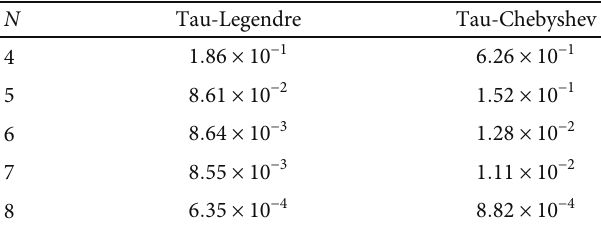
Table 4: L 2 w errors of the operational Tau methods for Example 3. N Tau-Legendre